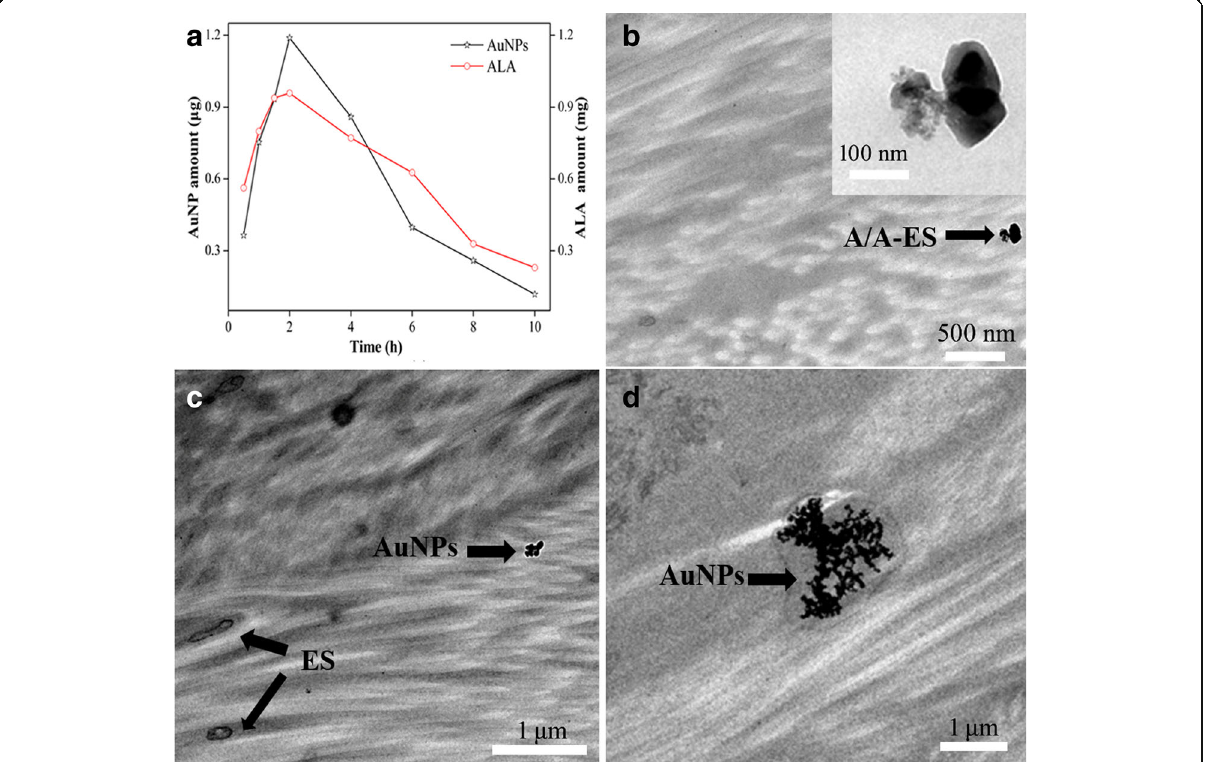
Fig. 2 a the retention amount of ALA and AuNPs. b The distribution of A/A-ES in HS tissue. c The distribution of ES and AuNPs in HS tissue. d AuNPs accumulating in HS